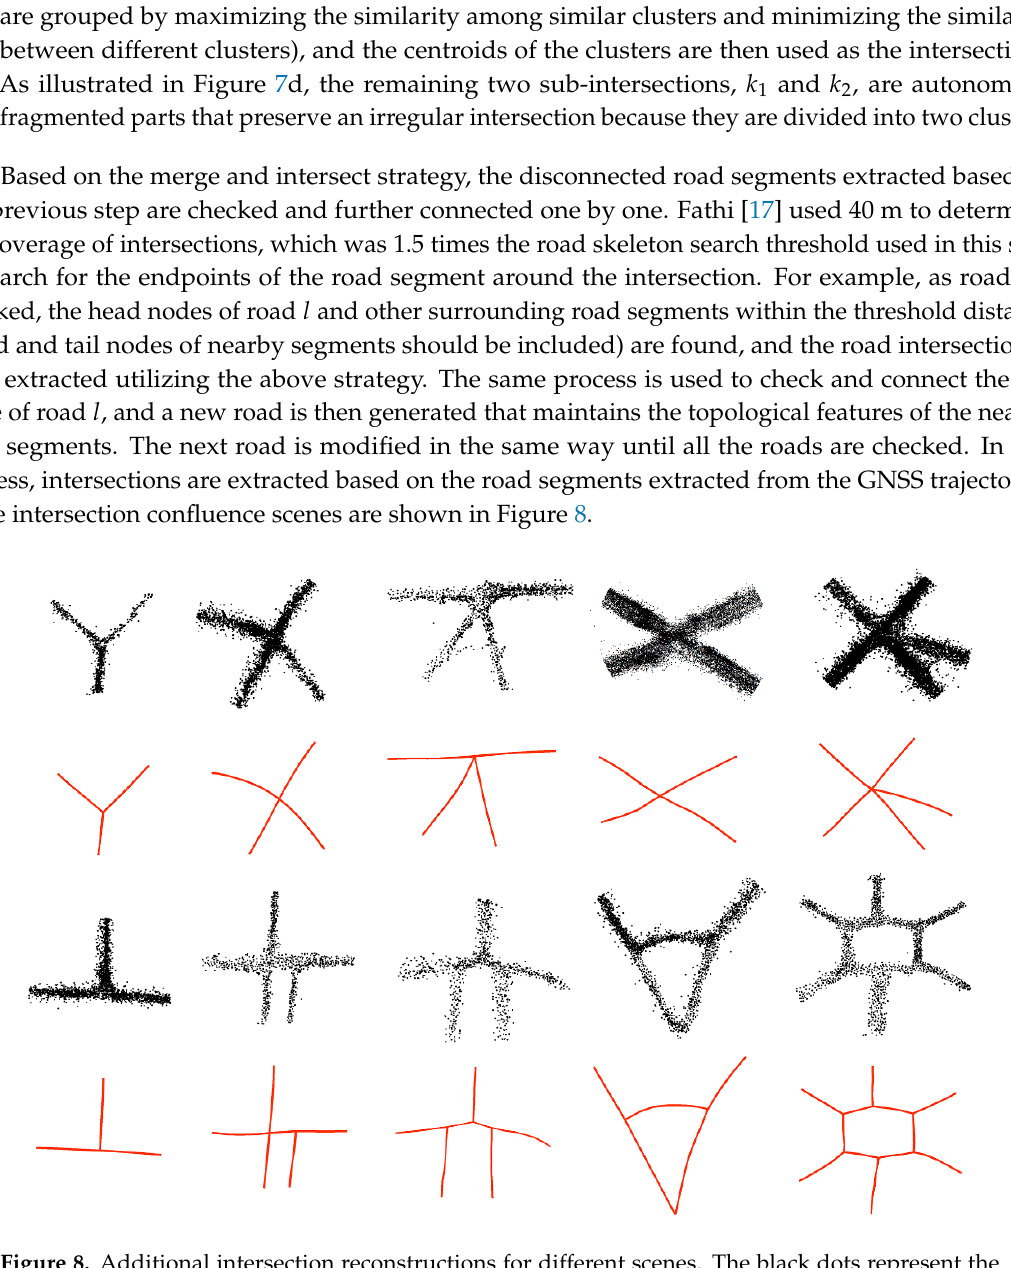
Figure 8. Additional intersection reconstructions for different scenes. The black dots represent the GNSS track point inputs, and the red lines represent the extracted roads for which the topological features are preserved. When an intersection has two or more dominant orientations, all the orientations of the intersection converge to the location of the intersection.